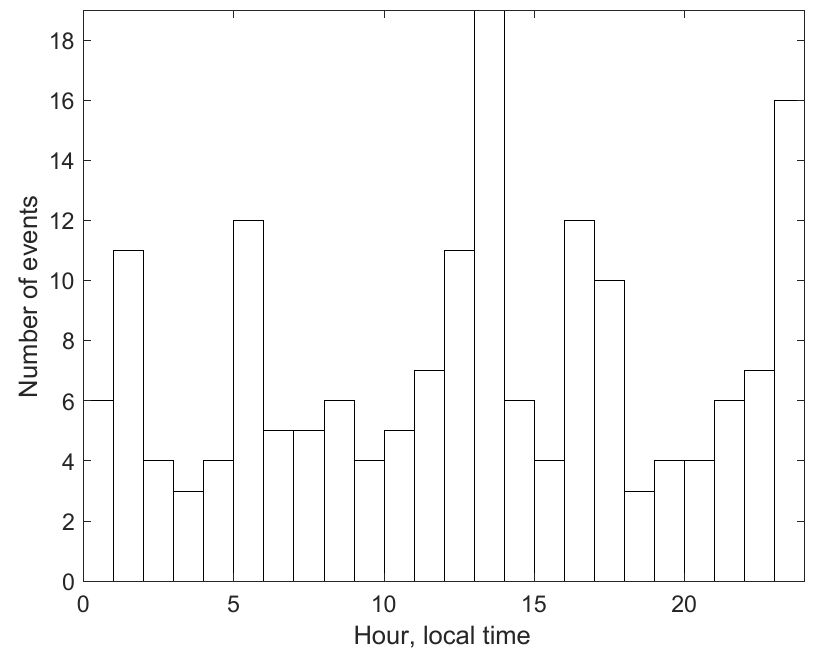
Figure 2. Distribution of seismic events over the time of the day.